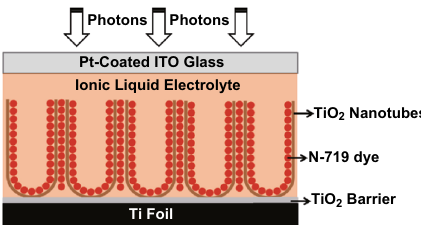
Fig. 14 Schematic illustration of the configuration of DSSCs based on TNTs [125]. Copyright (cid:2) 2012 American Chemical